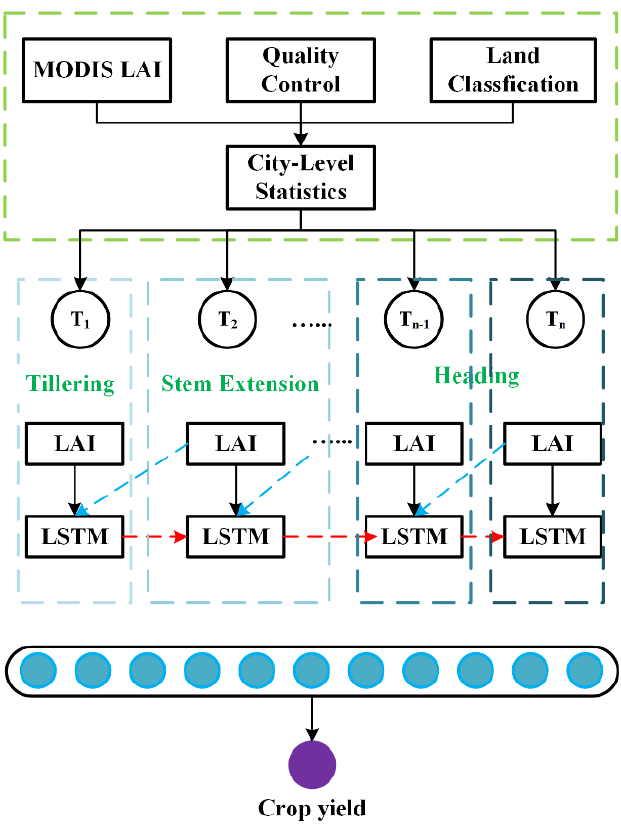
Figure 4. Overall structure of the LSTM model for wheat yield estimation.